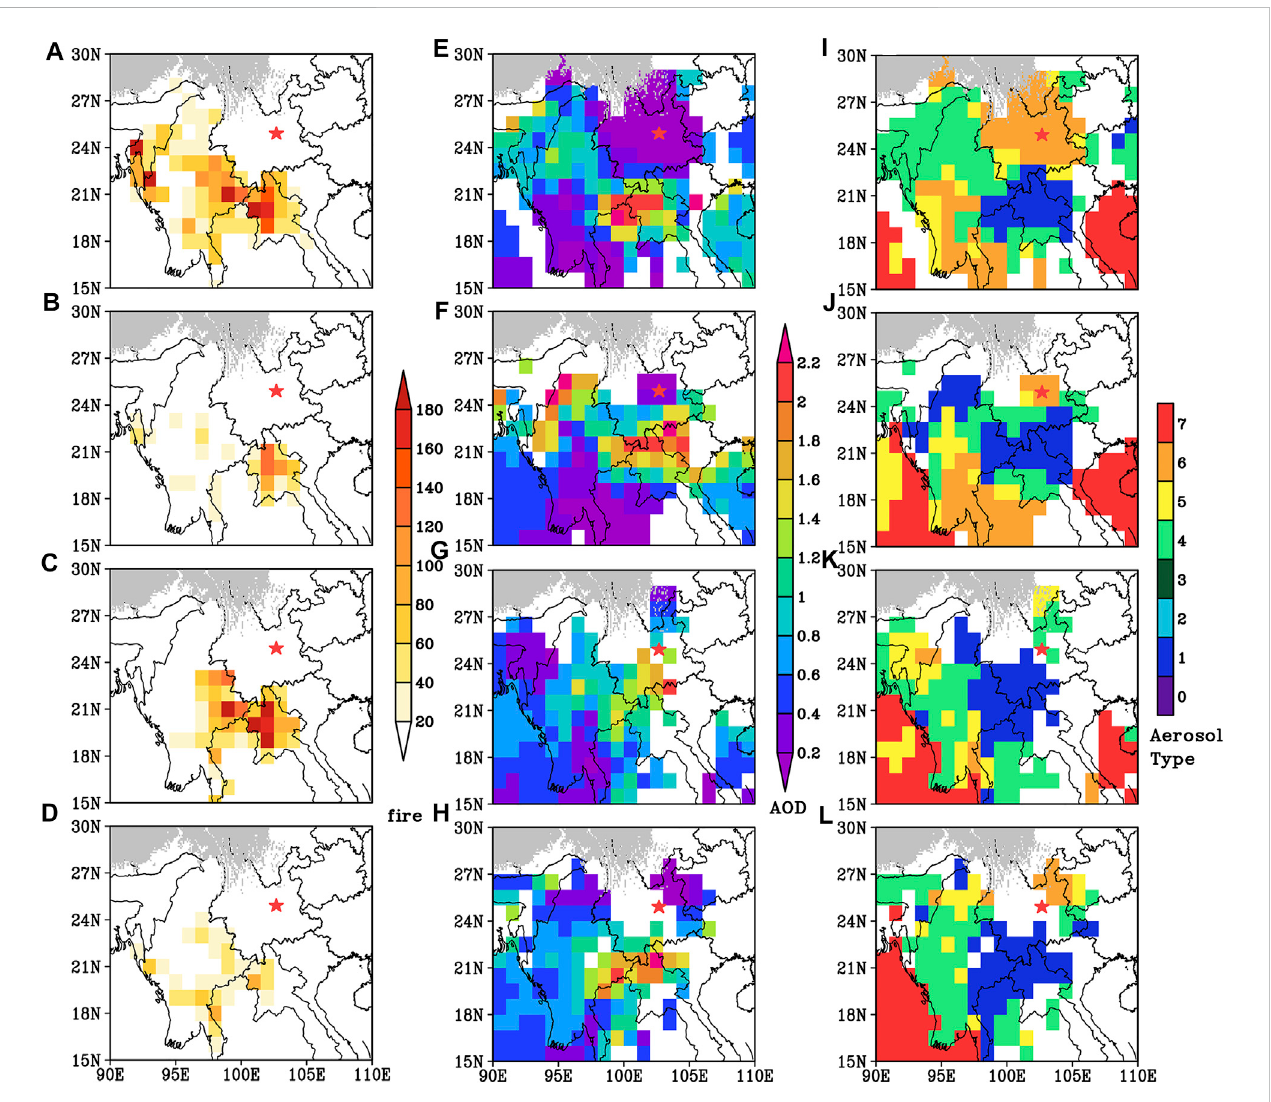
FIGURE 6 MODISretrieveddailymean (A – D) fi respots,VIIRSretrieveddailymean (E – H) AODand (I – L) aerosoltypefrom30March2019to2April2019,where0= dust(land+ocean), 1=smoke,2=highaltitudesmoke,3=pyrocumulonimbusclouds,4=non-smoke fi nemode,5=mixed(land+ocean),6=background (land + ocean maritime), and 7 = fi ne dominated. The red star denotes the location of Kunming